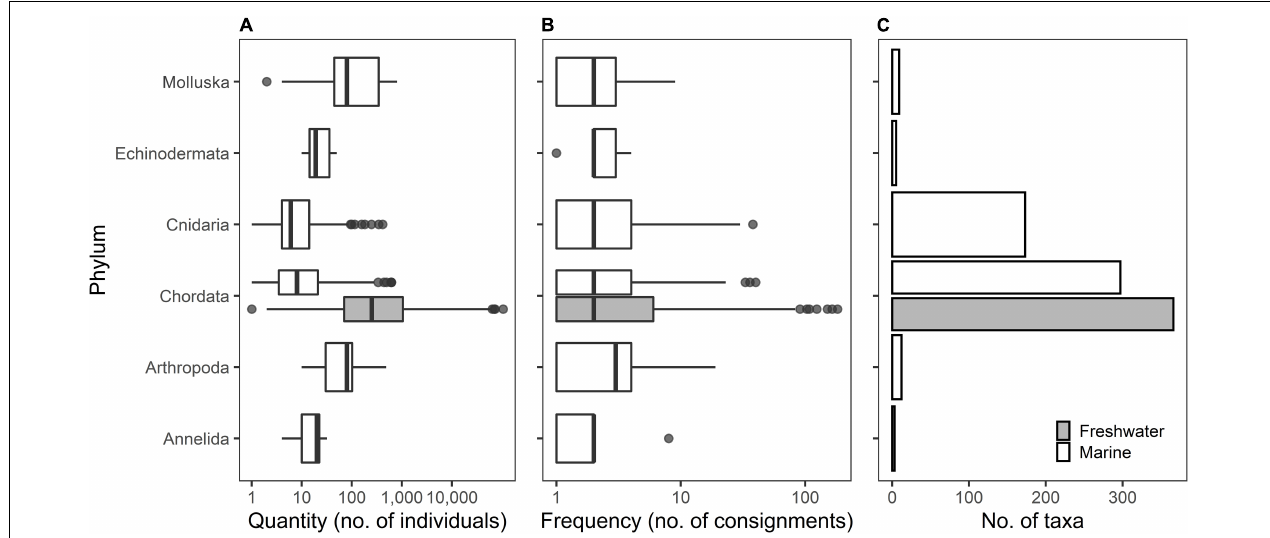
FIGURE 2 | Box plots of quantity (A) and frequency (B) , and bar plot of number of taxa (C) of imported aquatic ornamental species by phyla into New Zealand from 2015 to 2019 (inclusive). Lines in boxes are medians, box ends are lower and upper quartiles, and whiskers extend to the lowest or highest data point ≤ 1.5 the interquartile range. Black dots are outliers. Note that boxplots of quantity and frequency are in a log scale. Shading to indicate freshwater data applies to panels (A–C) .